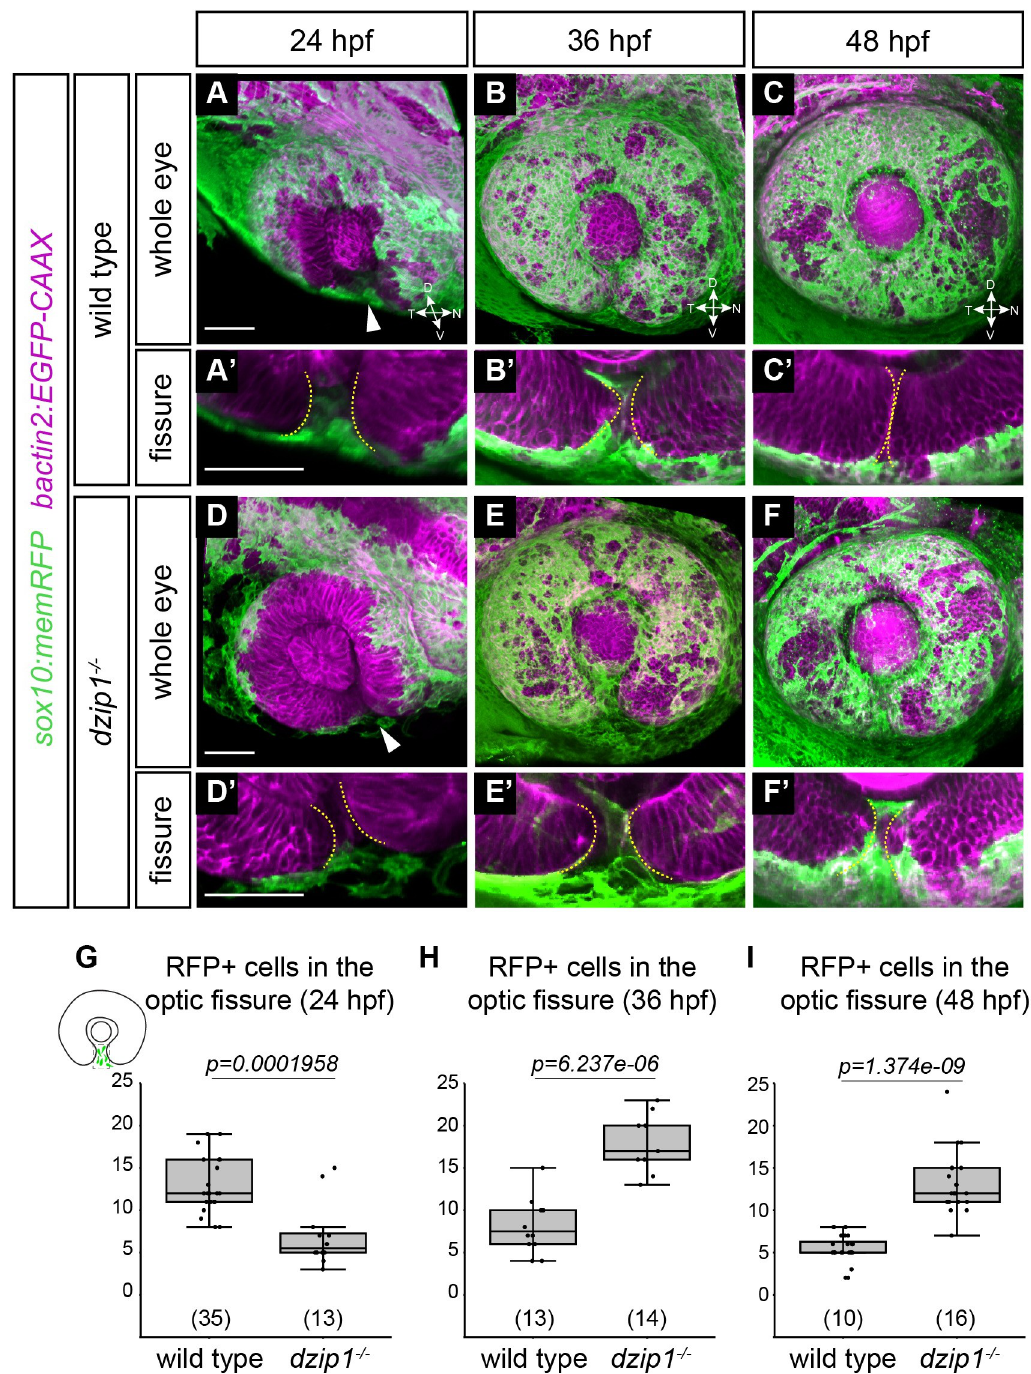
Fig 6. Tg(sox10 : memRFP)- positive neural crest cells do not properly localize in the optic fissure in dzip1 mutants. Embryos visualized for neural crest ( green ; Tg(sox10 : memRFP) ) and cell membranes ( magenta ; Tg(bactin2 : EGFP-CAAX) ) in wild type (A-C) and dzip1 ts294e mutants (D-F) at 24 hpf (A, D), 36 hpf (B, E), and 48 hpf (C, F). (A’-F’) Zoomed views of images in A-F to facilitate visualization of neural crest cells within the optic fissure. All images are lateral views of 3-dimensional renderings. Some Tg(sox10 : memRFP) -positive neural crest cells are detectable in the optic fissure by 24 hpf in both wild type and dzip1 -/- embryos ( white arrowheads in A, D). (G-I) Quantification of total number of Tg(sox10 : memRFP) -positive cells through the length of the optic fissure within the eye at 24, 36, and 48 hpf. n (embryos) for each genotype shown at the base of the graph. P -values were calculated using Welch’s t-test (M-O). Scale bar: 50 μ m. D, dorsal; V, ventral; N, nasal; T, temporal.